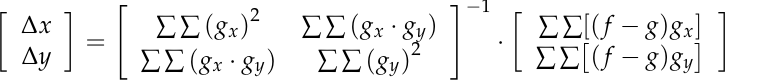
obtained using Equation (4), the total displacement for point P along x and y direction are u + ∆ x and v + ∆ y , respectively.